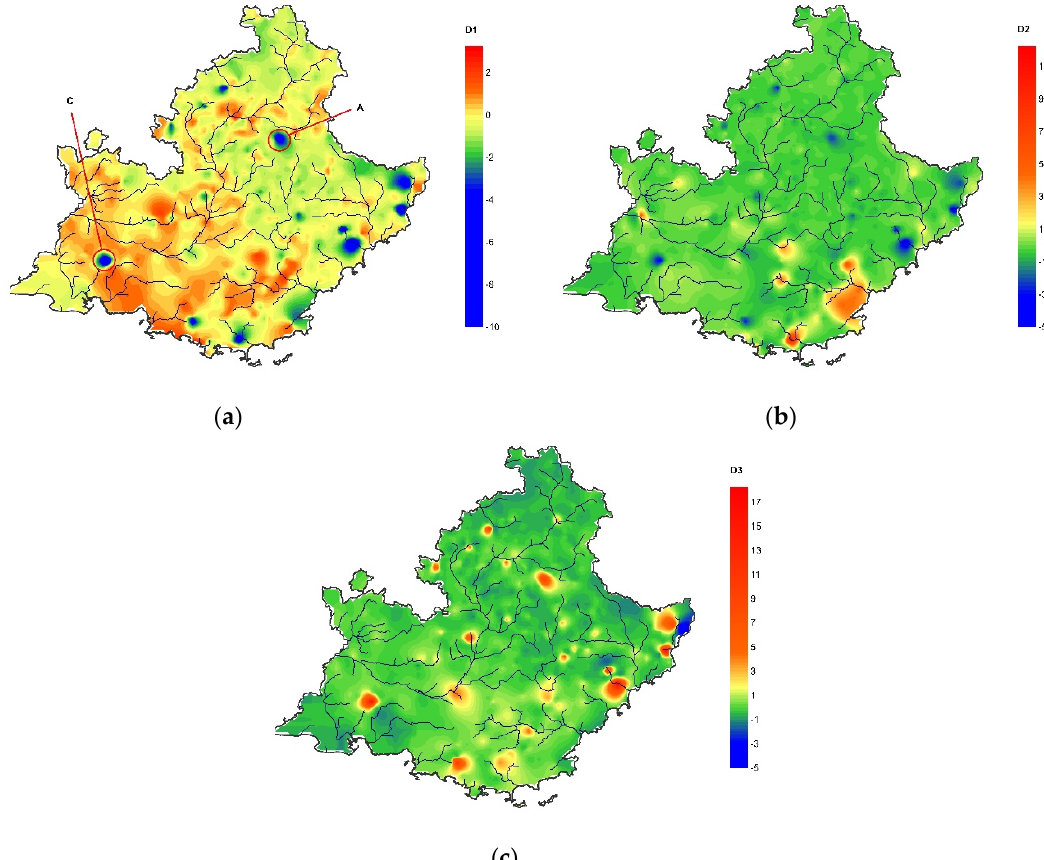
Figure 7. Distribution of the three first principal components D1, D2 and D3 ( a , b and c , respectively) after orthomax rotation.